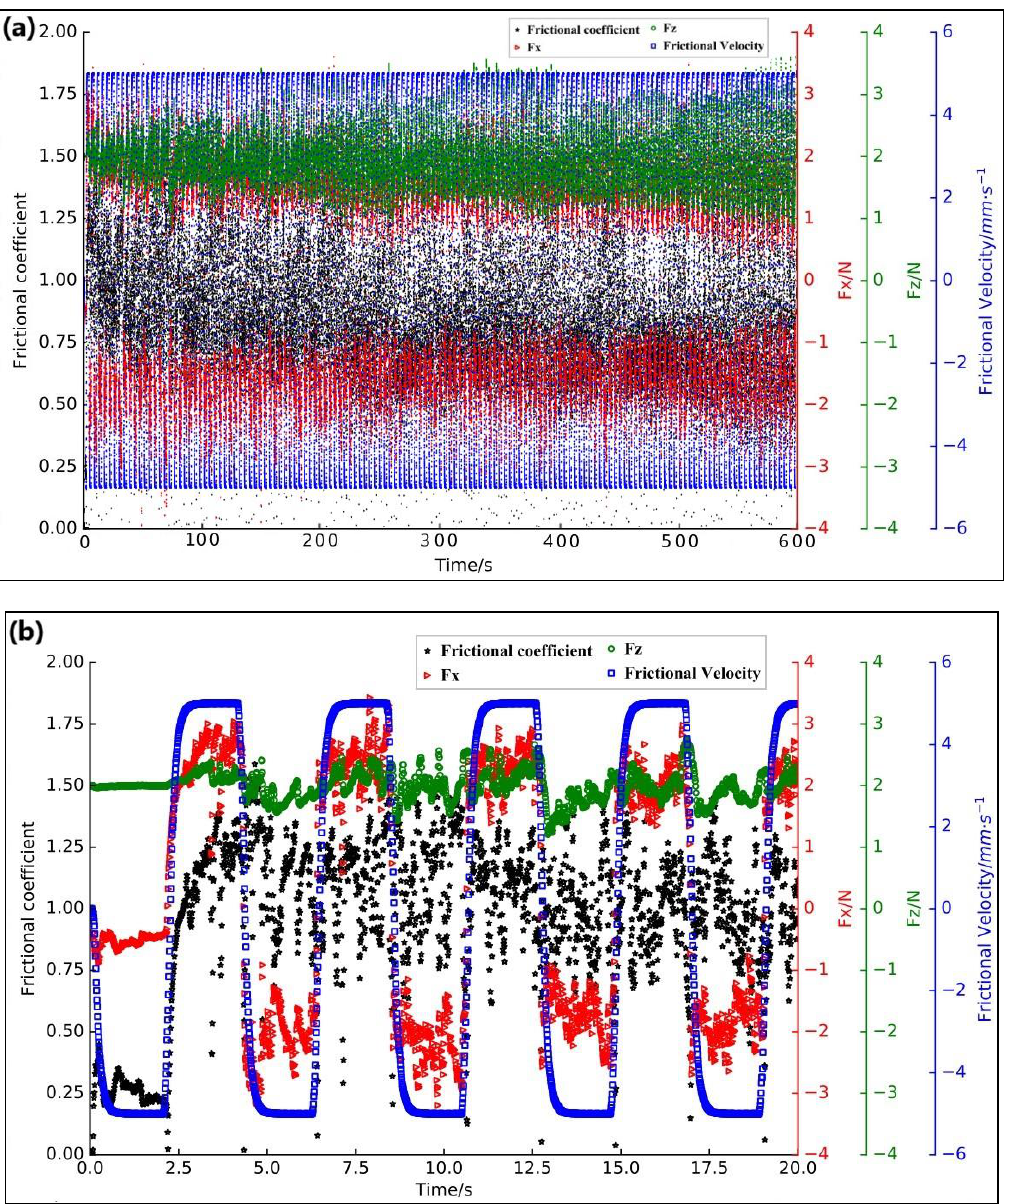
Figure 12. Friction test results of Al6061 sample: ( a ) the original data, ( b ) the data with 2.5 s~20 s.